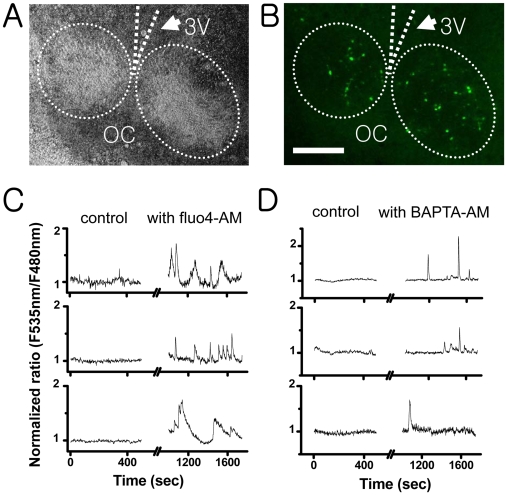
The effect of fluo-4 AM and BAPTA AM on the [Ca2+]c level of rat SCN cells expressing cameleon (pCMV/YC):The transmitted-light image (A) and fluorescent-light image (B) of a hypothalamic slice culture showing a pair of SCN (scale bar, 200 µm). This particular slice culture contained approximately 70–90 cameleon-expressing SCN cells. The cameleon-expressing cells were recorded for 450 seconds under the circulation of oxygen-saturated ACSF. Then the same samples were incubated under the ACSF containing 2.5-µM fluo-4 AM (C) or BAPTA AM (D) for 15 minutes, washed, and recorded again for another 500 seconds. None of the cells expressing cameleon had spontaneous Ca2+ spikes before the treatment with fluo-4 AM or BAPTA AM, but approximately 13∼15% (17 out of 118 cameleon-expressed cells in a fluo-4 AM-treated sample, 20 out of 155 cells in a BAPTA AM-treated sample) of the cameleon-expressing cells exhibited Ca2+ spikes after the treatment with fluo-4 AM or BAPTA AM. (C) and (D) are a typical example of the responding cells.